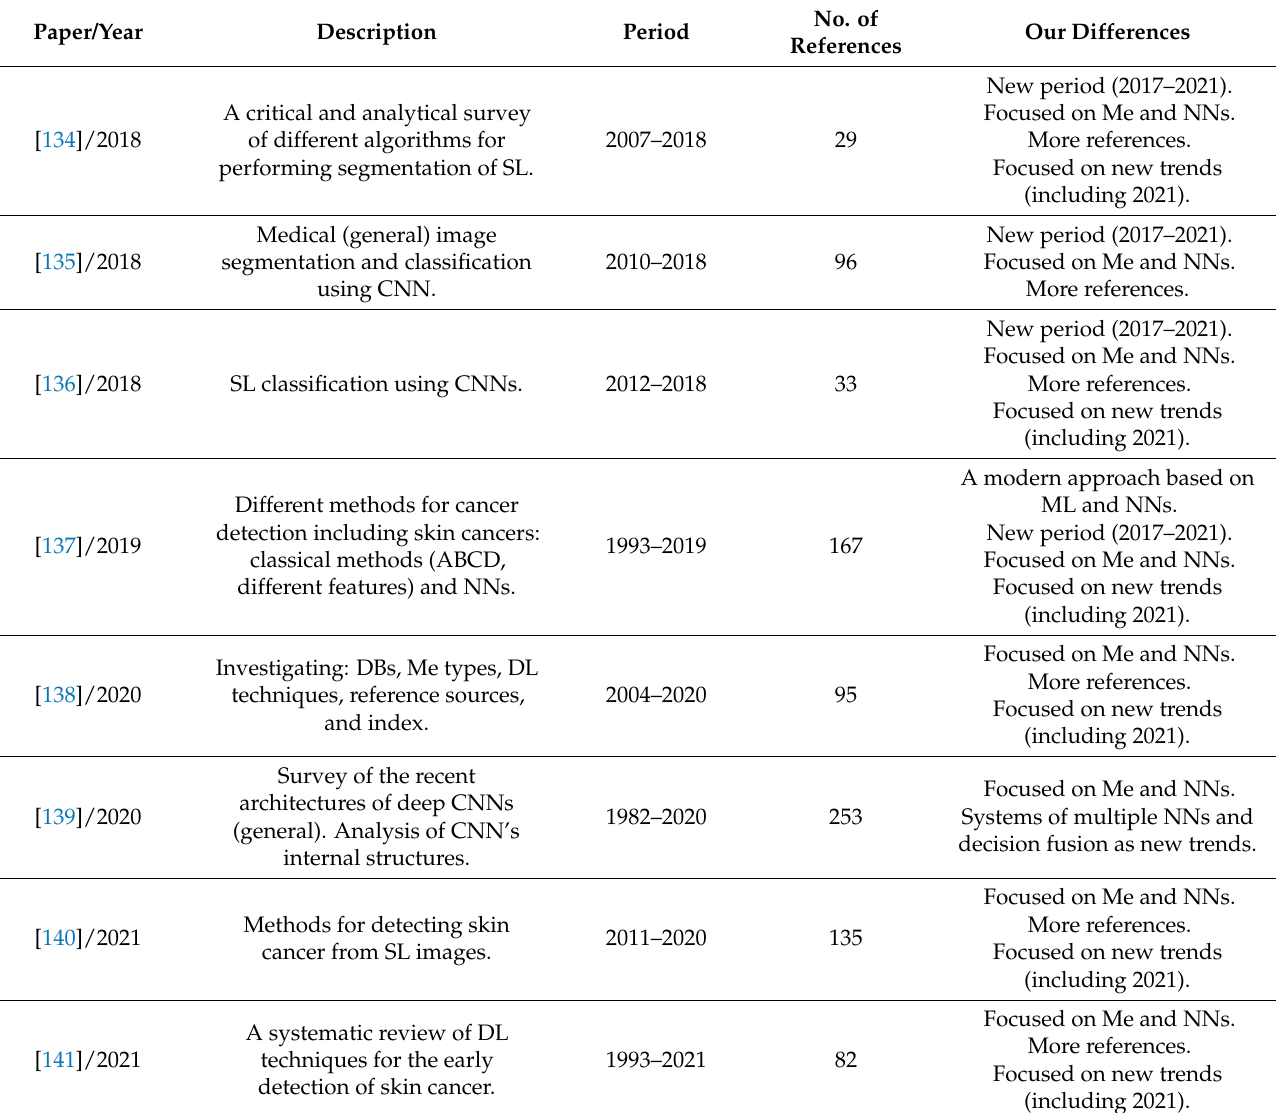
Table 5. Recent review/survey papers on similar